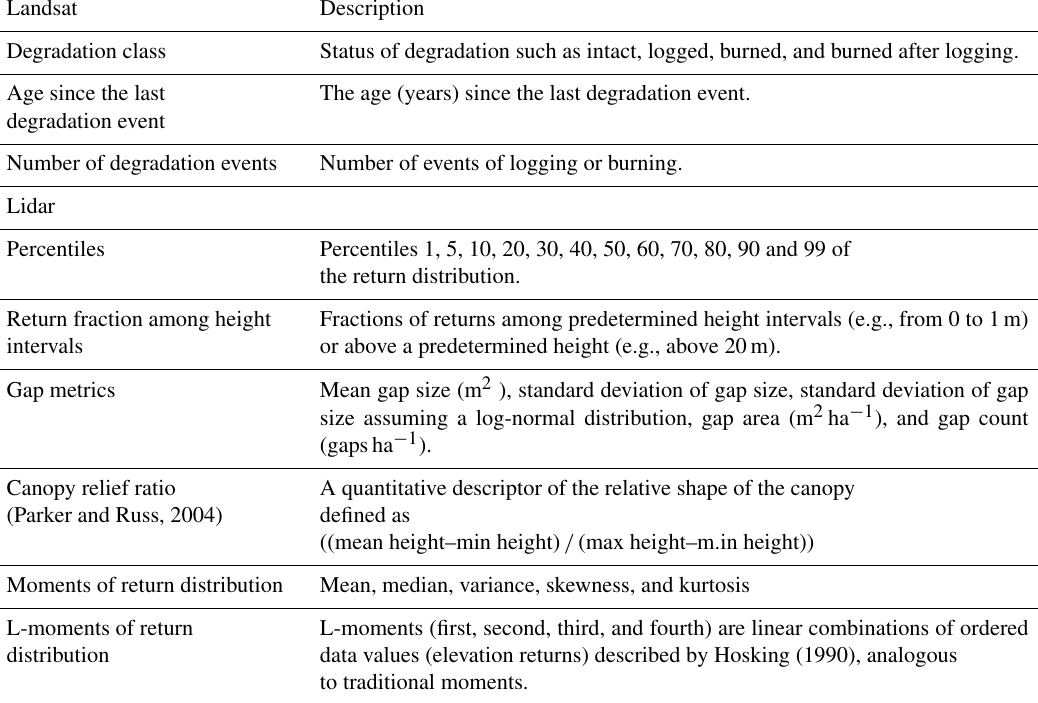
Table 2. Landsat-derived variables and lidar metrics used as potential covariates for modeling CDW in intact and degraded Amazonian forests.